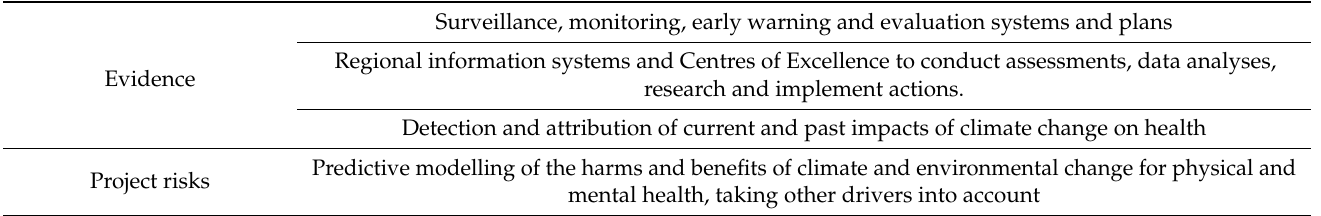
Table 4. Sub-competencies for Domain 3: Evidence, projections and assessments.